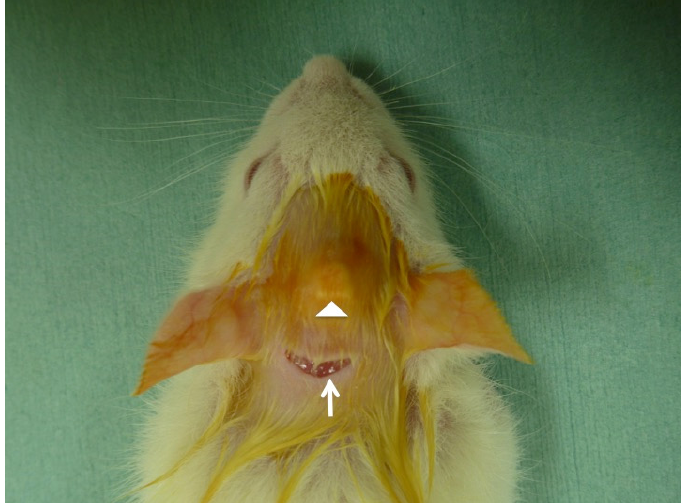
Figure 1. Implantation view of partially dissolved and precipitated hydroxyapatite (PDP-HAp). Arrowhead showing uplift under head skin just after implantation. Arrow indicating incision line.